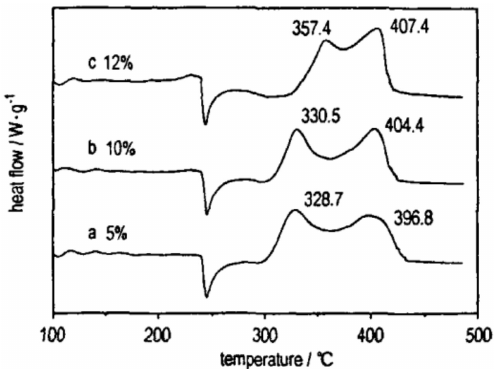
Figure12. DTAcurvesofAPwithdi ff erentratiosofnano-sizedAl / B / Nicompositeparticles. Reproduced from [50], with permission from Han Neng Cai Liao,